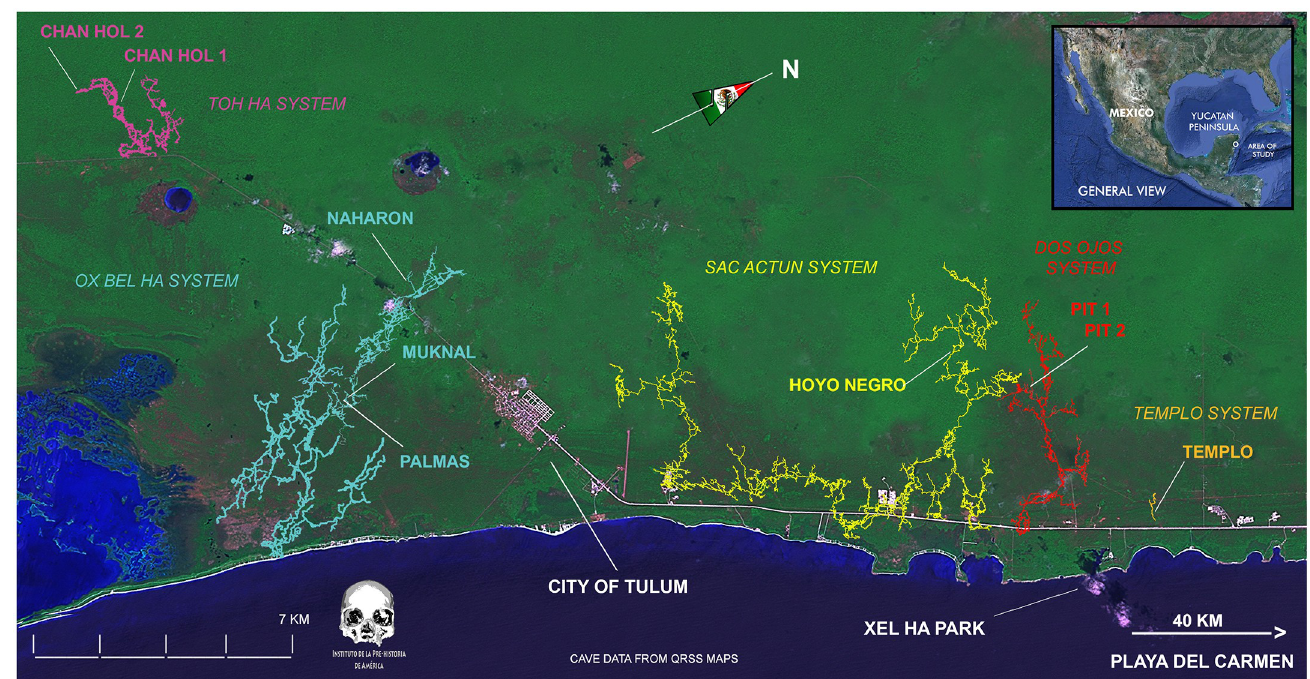
Fig 1. Coast of the Mexican State of Quintana Roo with location of cenotes and caves containing sites with human skeletons and associated Pleistocene fauna. The area is presently restricted to a 20 km North-South directed stretch close to Tulum and extends towards Playa del Carmen. All sites are between a few hundred meters to a maximum of 10 km from the recent coastline. Map created by JAO, using satellite image from USGS. Maps of the caves are available in [13].